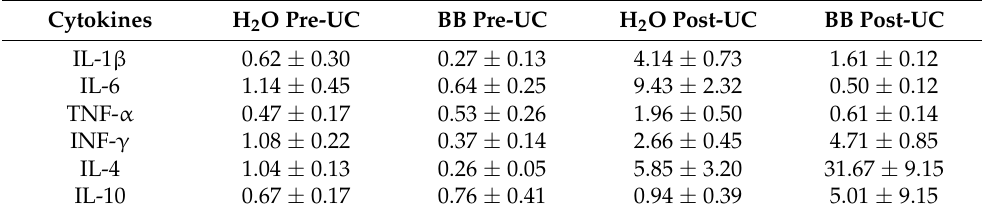
Figure 4. Evaluation of the treatments used on the expression of anti-inflammatory cytokines (2ˆ- ∆∆ Ct). The data is presented as the mean of each group, the bars indicate the standard error and the letters on each column indicate the statistical differences. ** p ≤ 0.05, *** p ≤ 0.001. The prophylactic administration of BB in the murine model of UC (BB post-UC) reduced histological damage and prevented the expression of IL-1 β by 61.12%, IL-6 by 94.70%, and TNF- α by 68.88%, increased the expression of INF- γ by 177.06%, IL-4 by 541.36% and IL-10 by 531.97%, concerning the control group that underwent UC induction (H 2 O post-UC) (Table 5). Table 5. Gene expression profile of cytokines of the evaluated groups. Data are presented as the mean of each